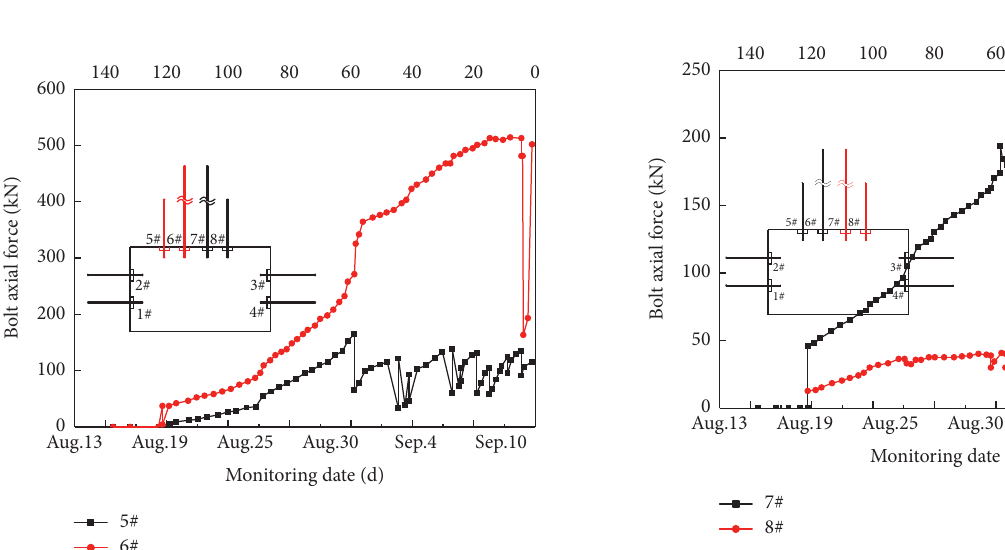
Figure 23: Hydraulic fracturing section: stress of the anchor cable at 2#